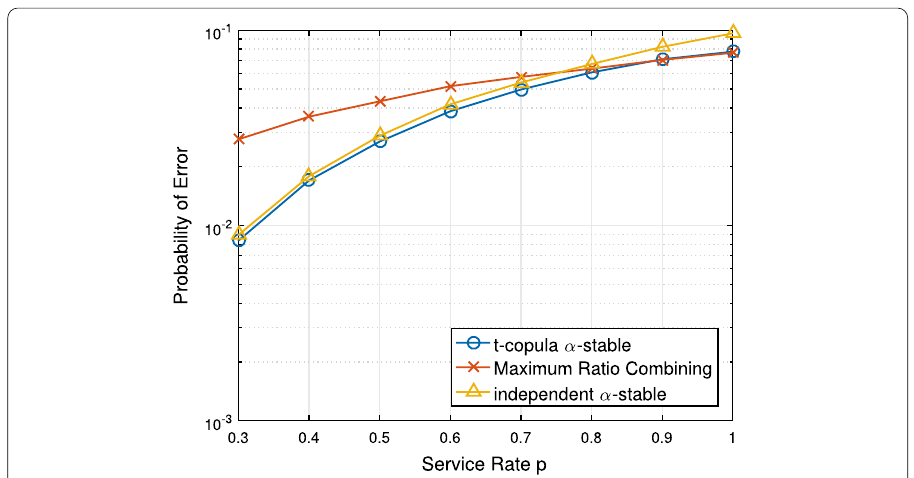
Fig. 8 Probability of error under different service rates, η = 3 , A = 0.01 and (cid:31) = 0.001 devices per m